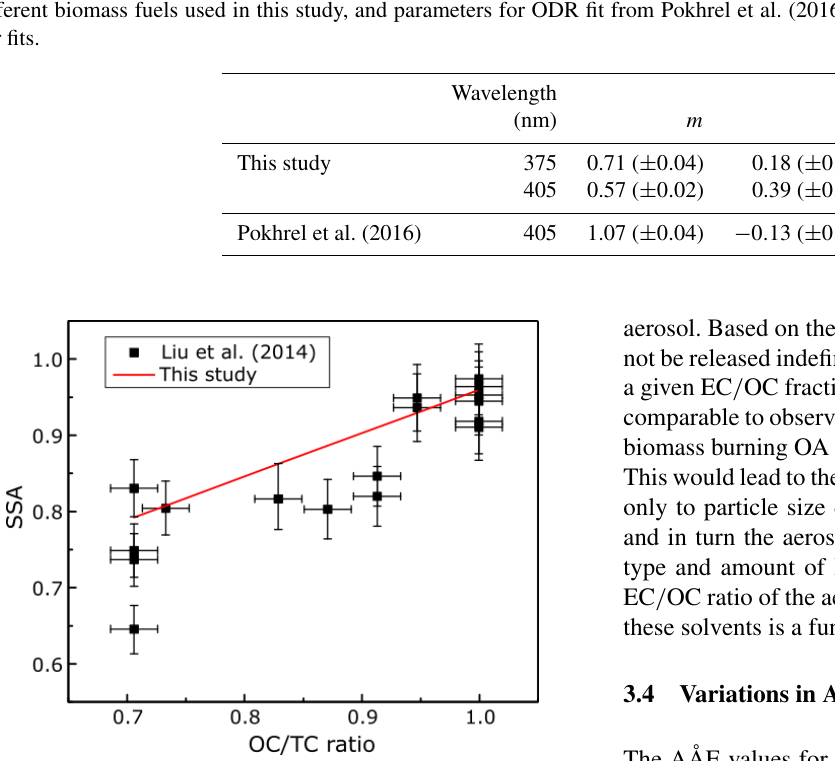
Figure 4. Measured SSA values by Liu et al. (2014) for controlled laboratory combustion experiments (black squares), and overlaid with the points is the ODR parametrization determined in this study (solid red